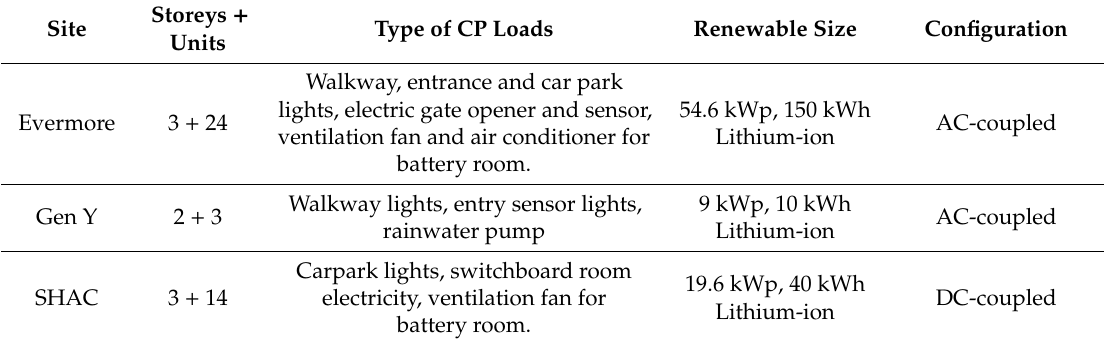
Table 1. Apartment site characteristics.